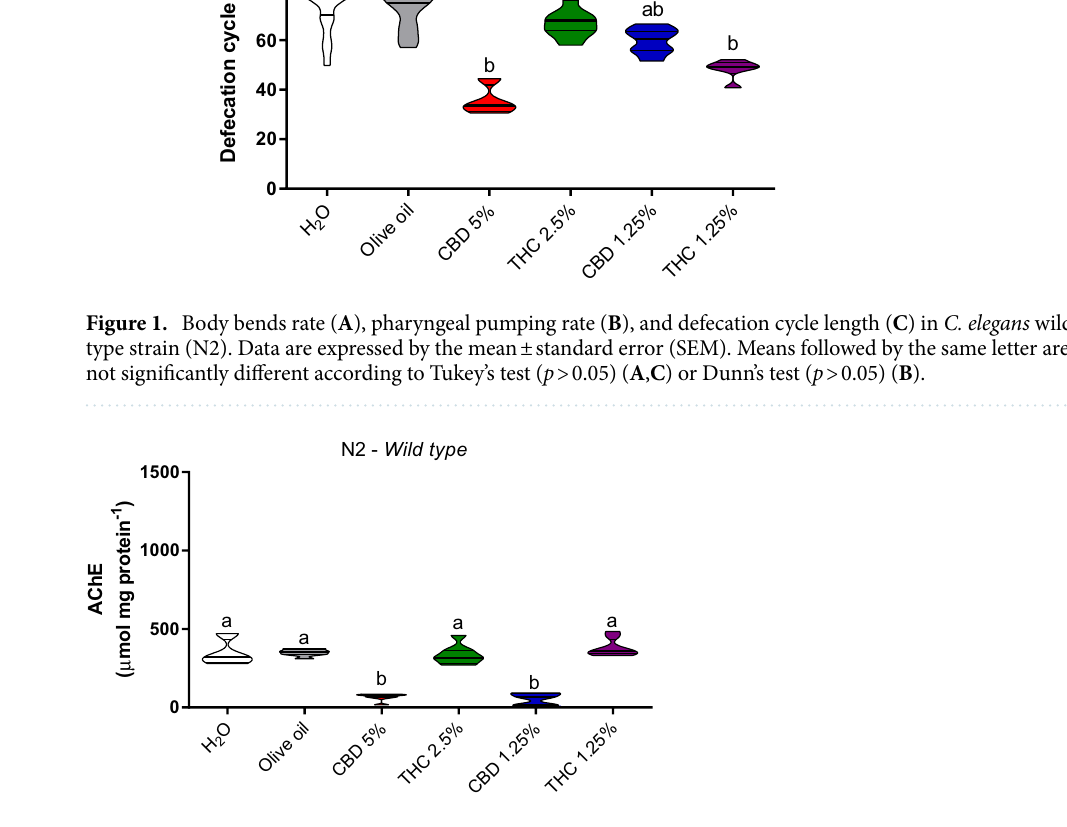
Figure 2. Acetylcholinesterase (AChE) activity in C. elegans wild-type strain (N2). Data are expressed by the mean ± standard error (SEM). Means followed by the same letter are not significantly different according to Tukey’s test ( p >